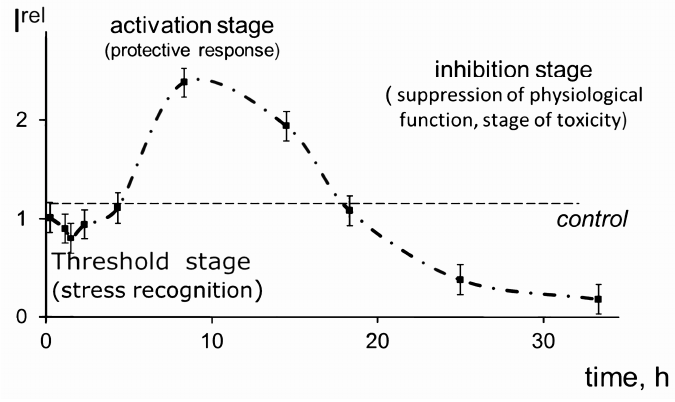
Figure 5. Bioluminescence kinetics of bacteria in a solution of americium-241, 3 kBq / L.